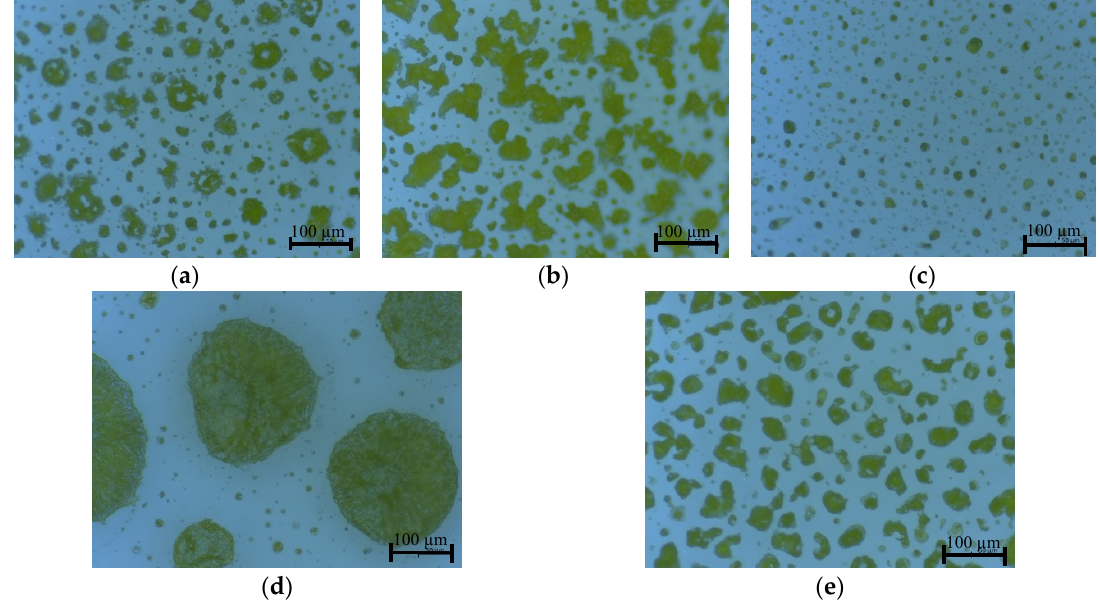
Figure 2. Optical microscope images for the spray coating with the different fabrication parameters: type 1 ( a ); type 2 ( b ); type 3 ( c ); type 4 ( d ); type 5 ( e ).